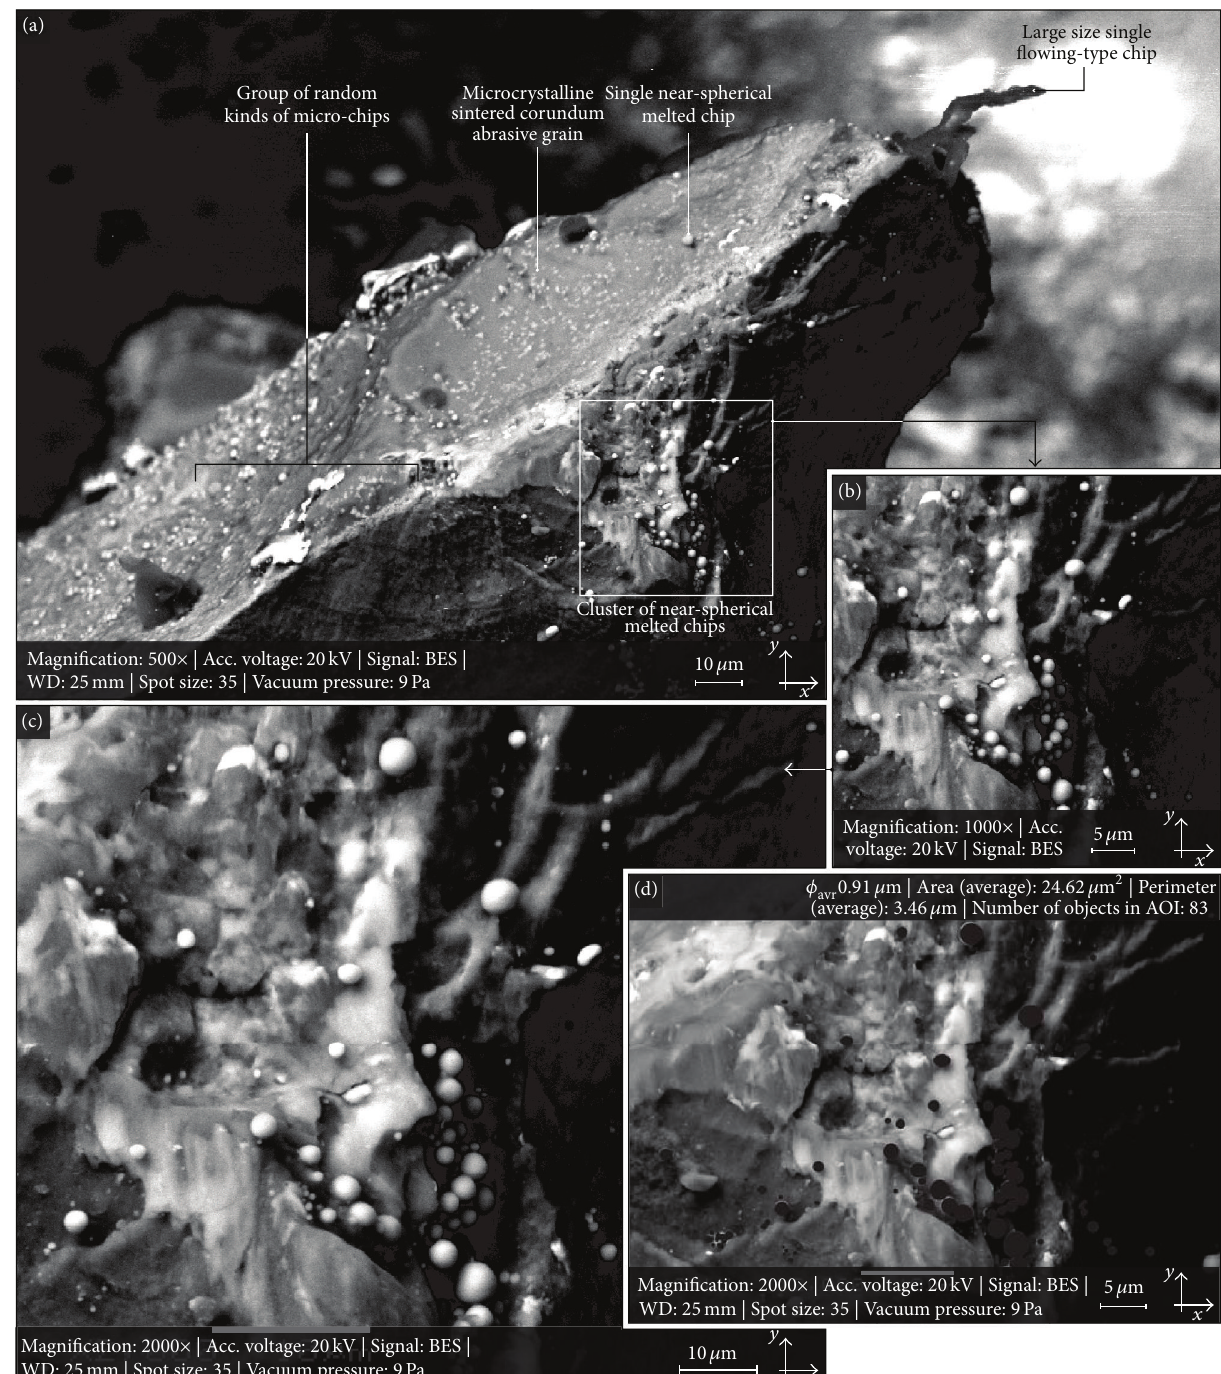
Figure 5: General morphology of cluster of near-spherical melted chips formed after internal cylindrical traverse grinding of 100Cr6 steel alloy obtained by use of scanning electron microscope JSM-550LV produced by JEOL: (a) SEM micrograph (size: 251.42 × 142.85 𝜇 m, mag. 500 × ) of GWAS 1–35 × 20 × 10-SG/F46K7VTO, showing area of concentration (cluster) of single near-spherical melted chips, (b) AOI (size: 41.42 × 41.42 𝜇 m, mag. 1000 × ) extracted from (a), (c) AOI (size: 101.89 × 85.25 𝜇 m, mag. 2000 × ) extracted from (b), and (d) SEM micrograph preparedforquantitativeanalysisinImage-ProPlus5.0software.Note:Acc.voltage,acceleratingvoltage;BES,backscatteredelectron(shadow image); WD, working